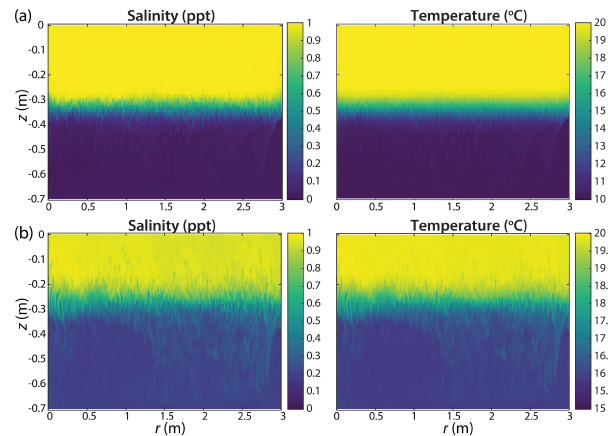
Figure 11. Salt fingering in a layered system with warm and saline water on top of a cold and fresh layer ( t with density ratios of (a) R ρ (Case 4). All figures represent simulations without the use of a tur- bulence